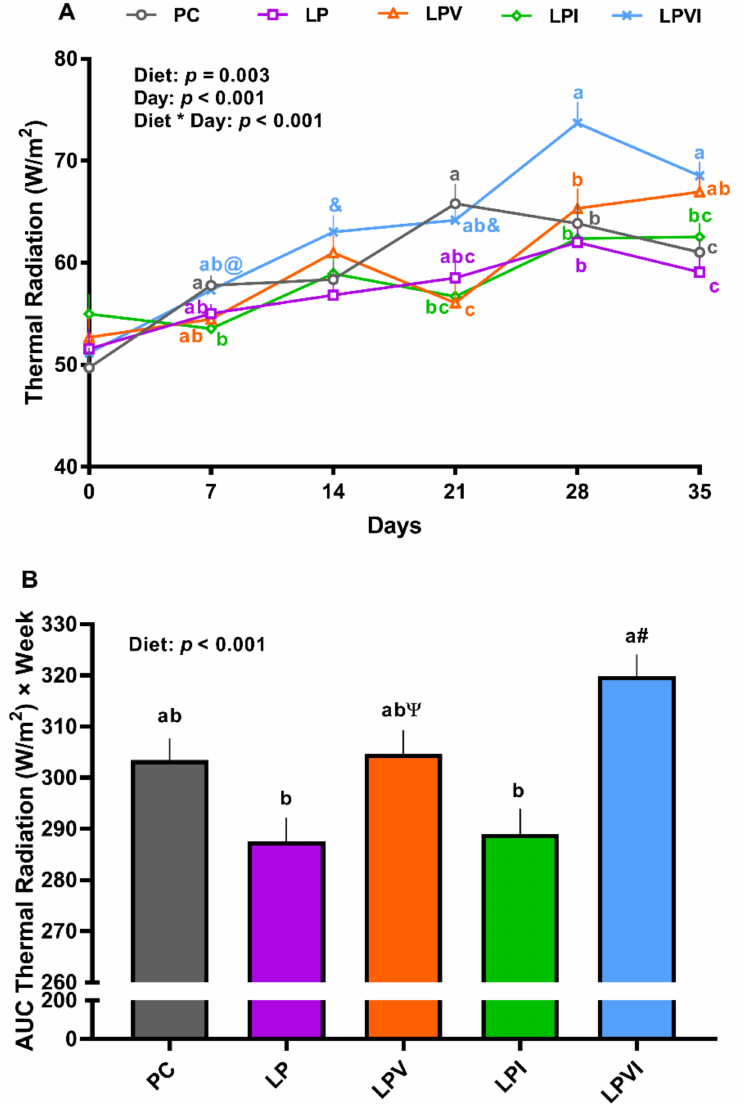
Figure 3. ( A ) Thermal radiation and ( B ) area under the curve (AUC) thermal radiation of nursery pigs fed with very-low-protein diets supplemented with Ile, Val, or combination of both. PC (positive control): standard-protein diet; LP (negative control): low-protein diet containing limiting amino acids (i.e., Lys, Met, Thr and Trp) at NRC (2012) levels; LPV: LP containing Val at NRC level; LPI: LP containing Ile at NRC level; LPVI: LP containing Val and Ile at NRC levels. The values are means ± standard error of the mean. n = 8. a,b,c Among groups, the means with different superscript letter(s) are different ( p ≤ 0.05). # p ≤ 0.1 LPVI vs. PC, Ψ p ≤ 0.1 LPV vs. LP, & p ≤ 0.1 LPVI vs.